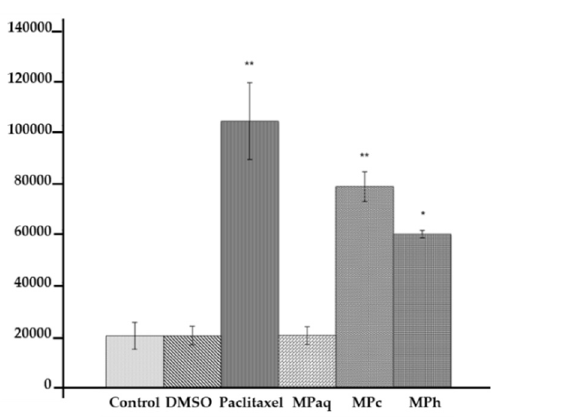
Figure 1. Caspase 3/7 activity in PC3 and LNCaP cells treated with the active extracts of Marantodes pumilum for 72 h. The y-axis shows the luminescent signal subtracted from a blank and is proportional to the activity of caspases. The error bars display the standard error of the mean (SEM) obtained from 3 independent experiments. Significance compared to control, * ( p < 0.05) and ** ( p < 0.01), as determined via unpaired t -test.